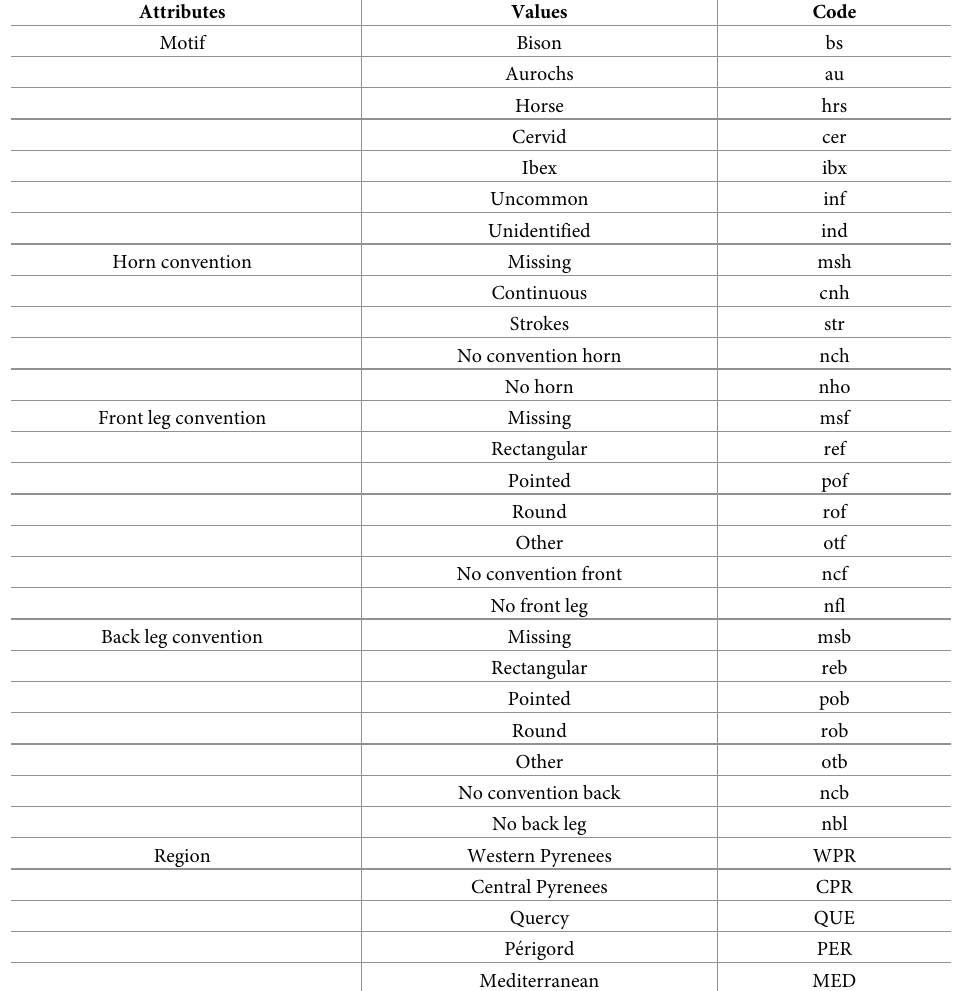
Table 3. Attributes and values used in the